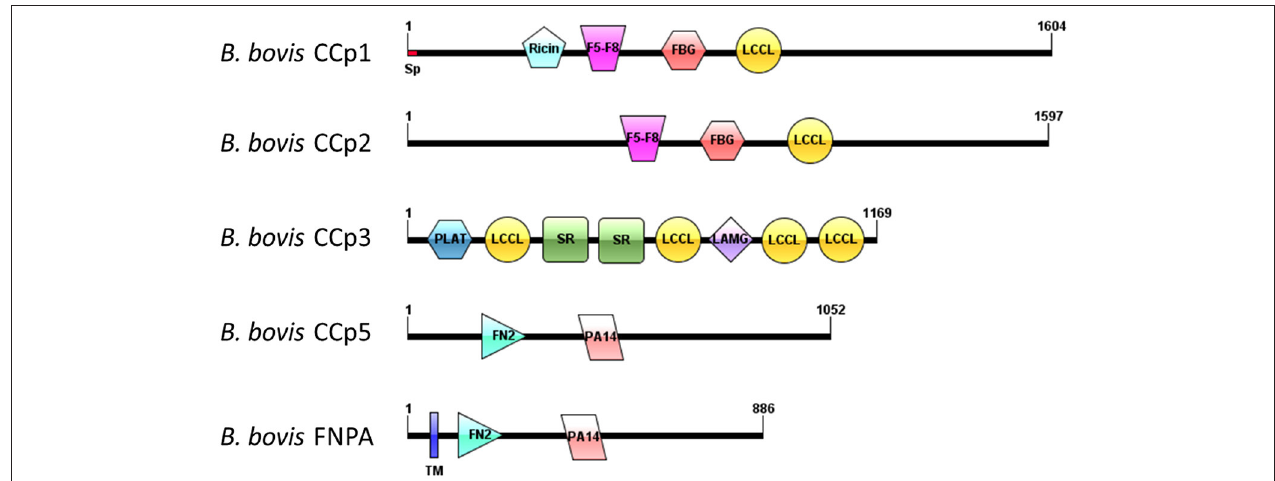
FIGURE 2 | Schematic domain architectures representation of all CCp family members of B. bovis , including the novel non-canonical members CCp5 and FNPA. Diagrams were constructed using IBS program ( 28), version 1.0. Domain abbreviations are as follows: Sp, signal peptide; Ricin, Ricin domain, F5-F8, F5-F8 type C domain, FBG, Fibrinogen-related domains; LCCL, Limulus coagulation factor domain; PLAT, Polycystin-1, Lipoxygenase, Alpha-Toxin; SR, Scavenger receptor domain; LAMG, Laminin G domain; FN2, Fibronectine type 2 domain; PA14, Anthrax PA domain; TM, transmembrane